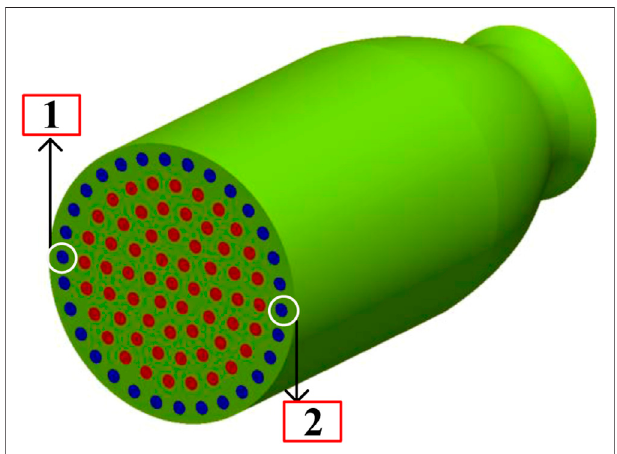
FIGURE 6 | Injectors with uneven distribution of propellant.